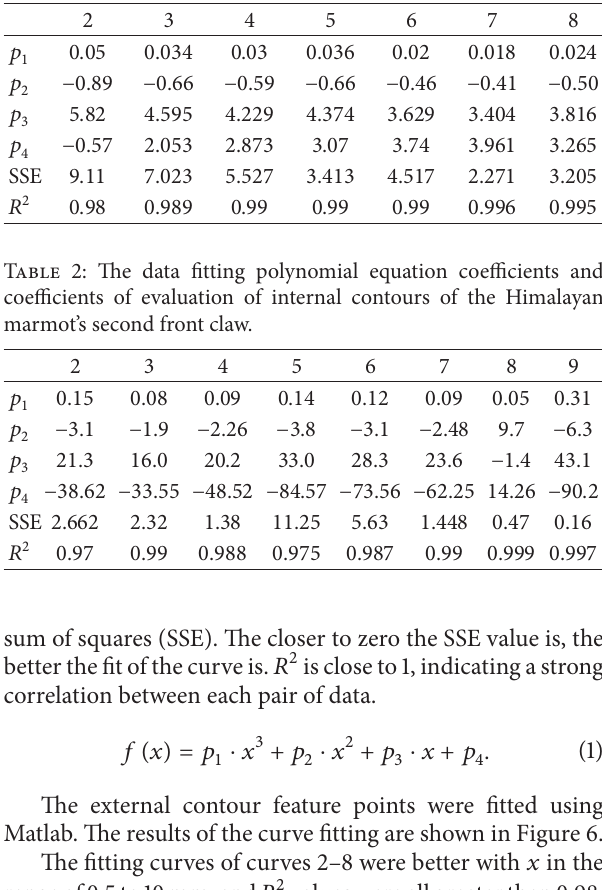
Table 1: The data fitting polynomial equation coefficients and coefficients of evaluation of the outer contours of the Himalayan marmot’s second front claw.